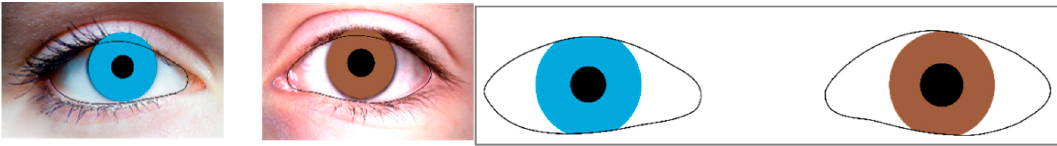
Figure 2. First approach to design a pair of artificial eyes based on images of real eyes.